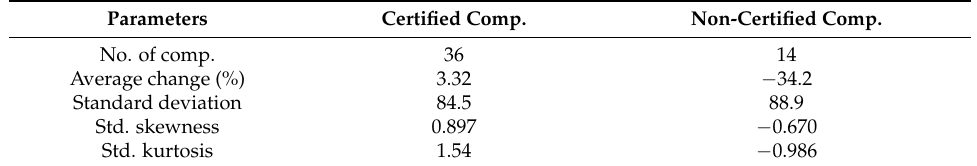
Table 6. Summary statistics on the change in fossil fuel efficiency improvement in the period